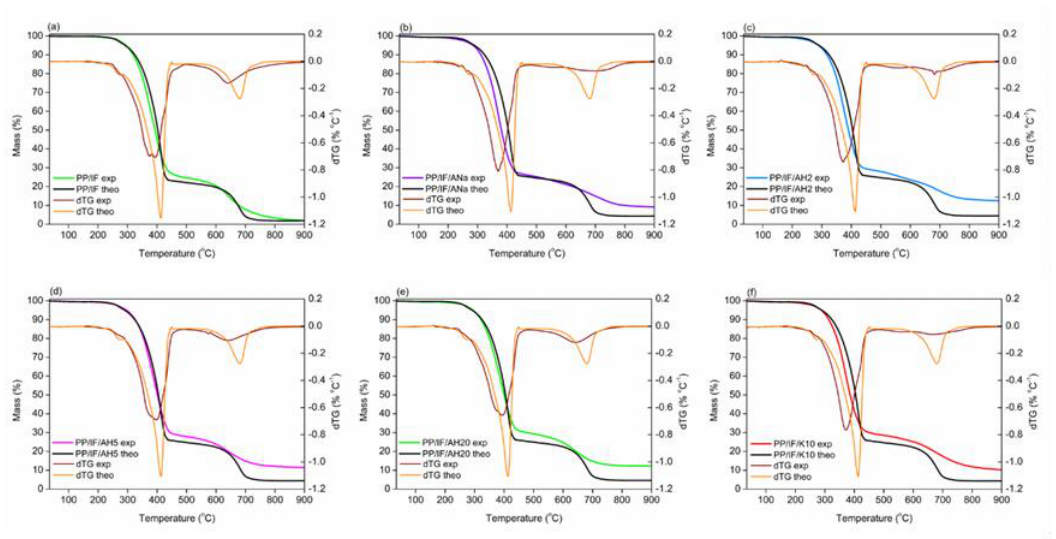
Figure 7. Comparison between the experimental and theoretical TGA and dTG curves for PP / IF and PP / IF / clay minerals systems. Left Y axis: Mass (%). Right Y axis: dTG (% ◦ C − 1 ): ( a ) composite without clay mineral; ( b ) composite with Ana; ( c ) composite with AH2; ( d ) composite with AH5; ( e ) composite with AH20; ( f ) composite with